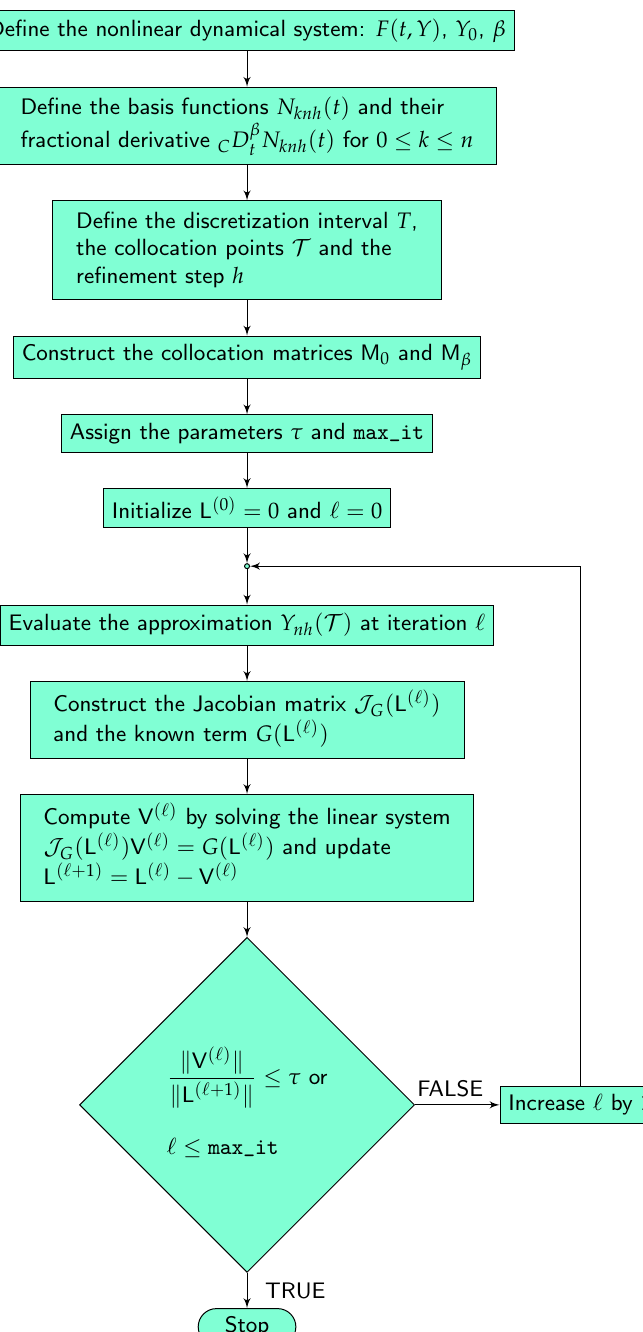
Figure 1. The flow chart of the collocation method described in Section